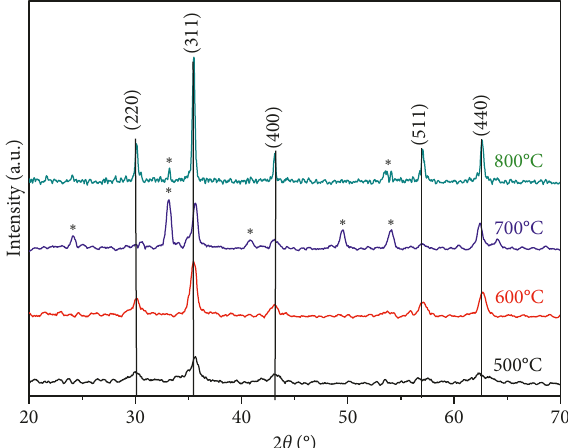
Figure 2: X-ray diffraction of MgFe 500 ° C to 800 °